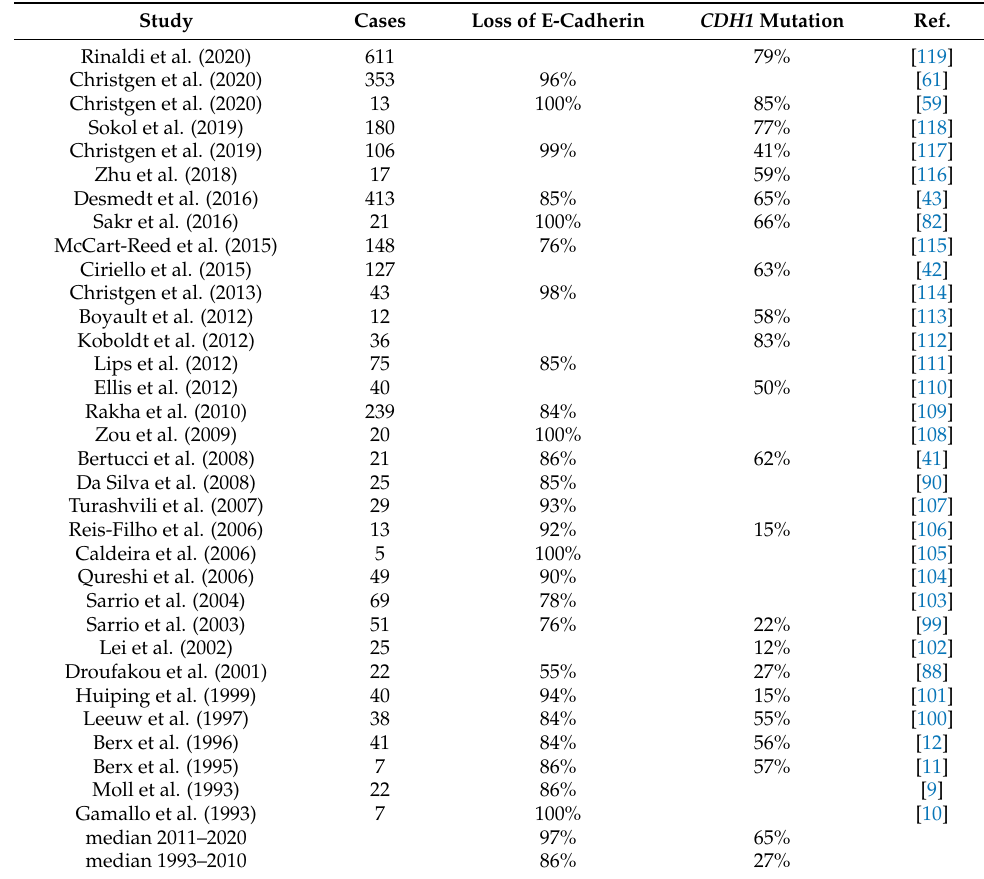
Table A2. Loss of E-cadherin and/or CDH1 mutation in